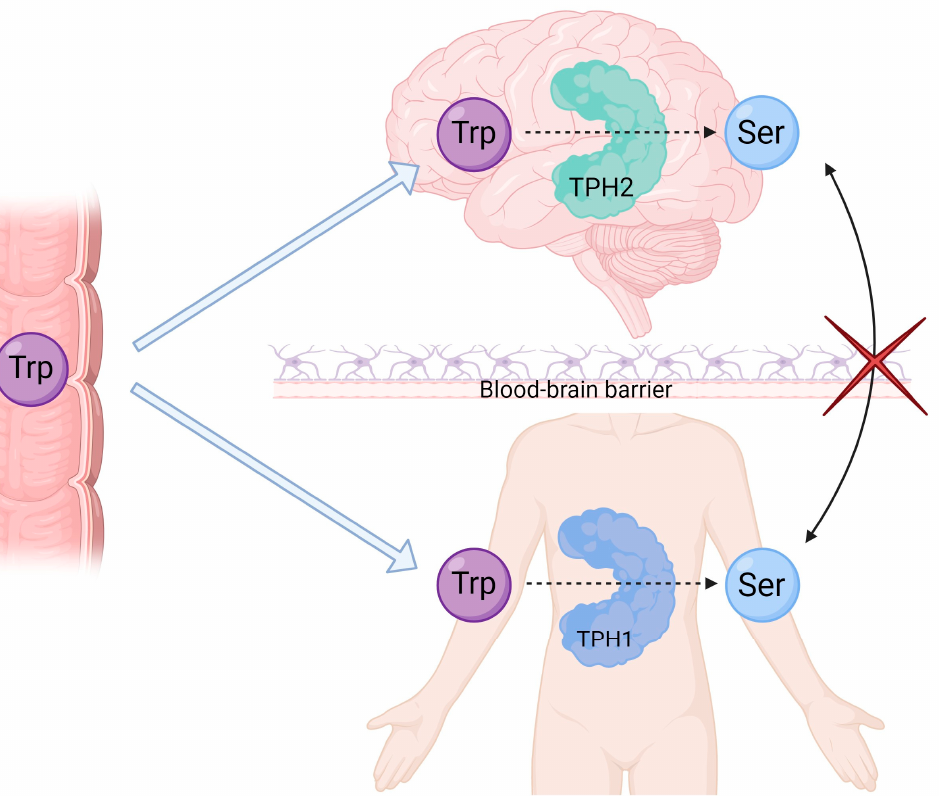
Figure 1. Formation of serotonin in the central nervous system (CNS) and periphery of the body. Tryptophan is absorbed through the intestines and is transported to the CNS, as it is non-polar and is able to cross the blood–brain barrier. Serotonin, which is a hydrophilic molecule and is thus unable to cross the blood–brain barrier, is produced separately in the CNS and the periphery through the process initiated by the tryptophan hydroxylase (TPH) enzyme specific to either region—TPH1 in the periphery of the body and TPH2 is specifically in the CNS. Created with